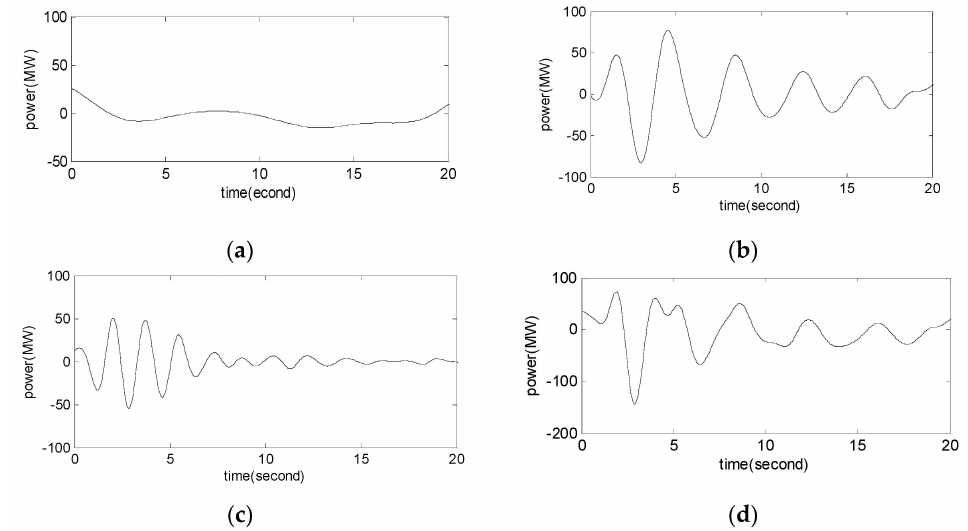
Figure 18. Fine analysis of frequency slices based on FSWT. ( a ) Reconstructed signal of [0, 0.2] Hz; ( b ) Reconstructed signal of [0.2, 0.5] Hz; ( c ) Reconstructed signal of [0.8, 2] Hz; ( d ) Reconstructed signal = ( a ) + ( b ) + ( c